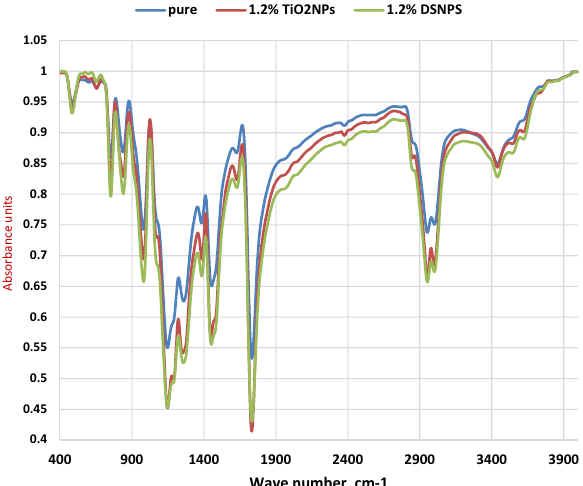
Figure 9. FTIR spectral curves for the raw and composite